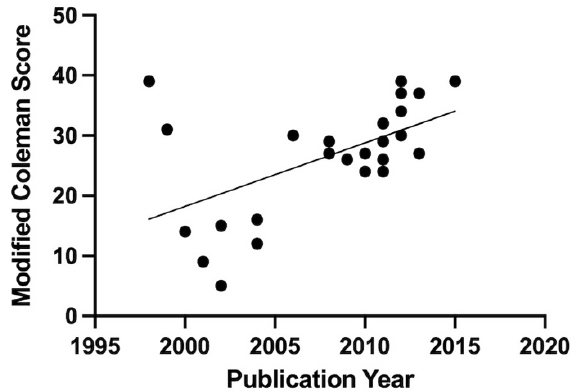
Figure 9. Time-dependent trend of clinical studies modified Coleman methodology score (CMS) from 1998 to 2017. The Mann–Kendall test showed an increasing trend between the modified CMS and time ( p = 0.004).